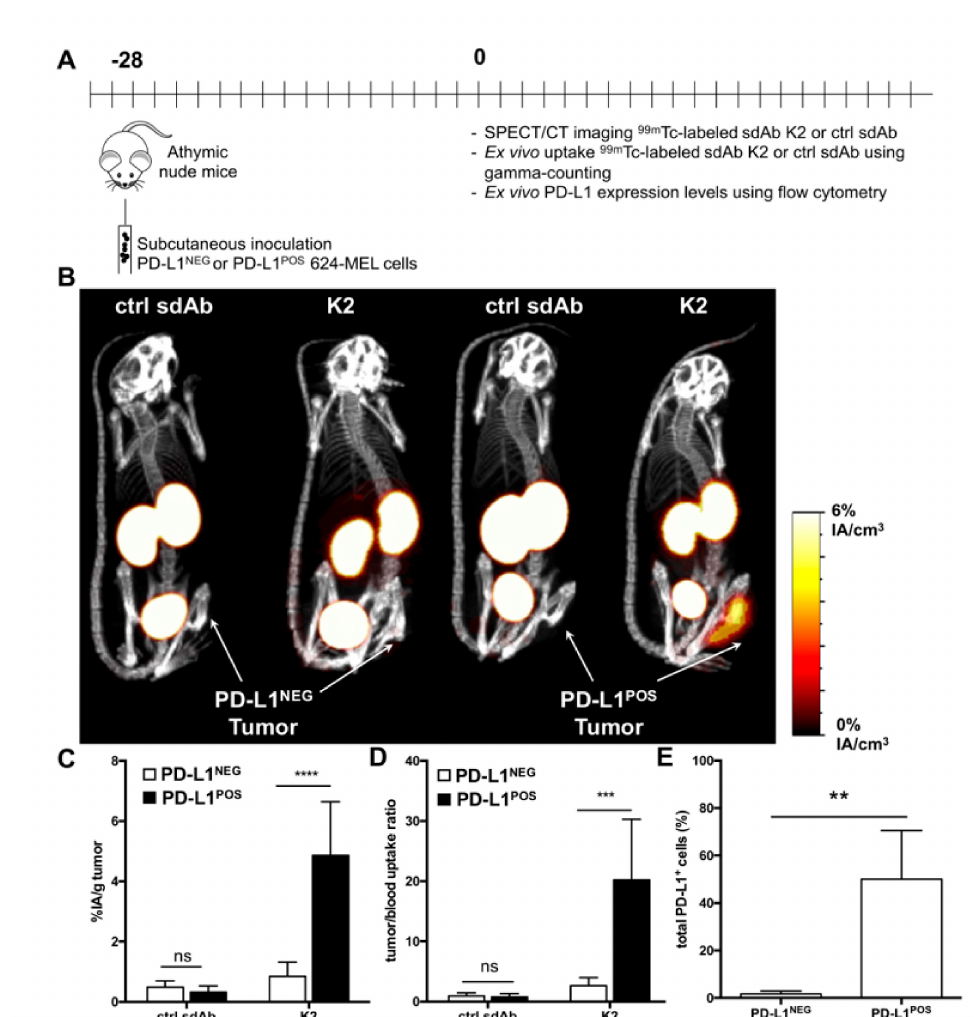
Figure 4. Radiolabeled sdAb K2 allows visualization of human PD-L1 POS melanoma tumors by nuclear imaging. ( A ) Scheme of the experimental setup. ( B ) SPECT / CT images showing the biodistribution of 99m Tc-K2 or 99m Tc-R3B23 (control sdAb) one hour after i.v. administration in athymic nude mice bearing PD-L1 NEG ( left ) or PD-L1 POS ( right ) 624-MEL tumors ( n = 6). ( C , D ) Ex vivo analysis of the accumulation of 99m Tc-sdAbs in dissected PD-L1 NEG or PD-L1 POS 624-MEL tumors ( C , expressed as %IA / g), and of tumor-to-blood uptake ratios ( D ), 80 min after i.v. radiotracer injection ( n = 6). ( E ) Percentage of human PD-L1 POS cells in tumors dissected from mice that were s.c. implanted with parental 624-MEL cells (PD-L1 NEG ) or PD-L1-modified counterparts (PD-L1 POS ), as measured by flow cytometry analysis of tumor single cell suspensions ( n = 6). ** p < 0.01, *** p < 0.001, **** p <